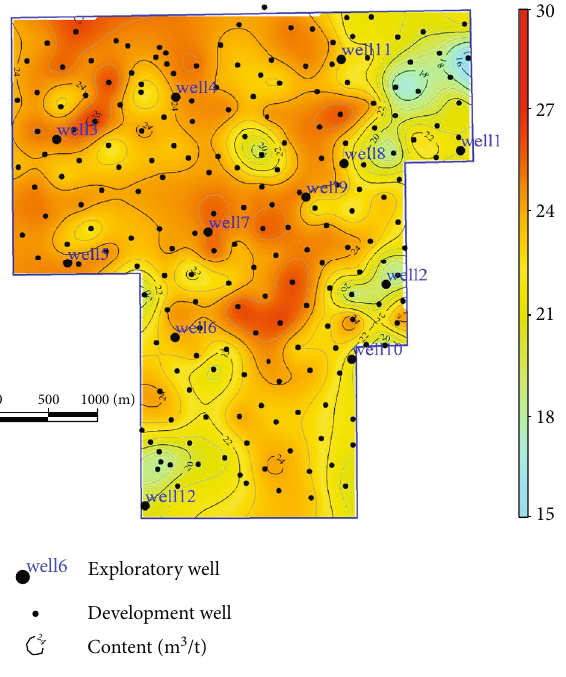
Figure 11: Calculation results of gas content in pH block. Table 5: Comparison of measured gas content with calculated gas